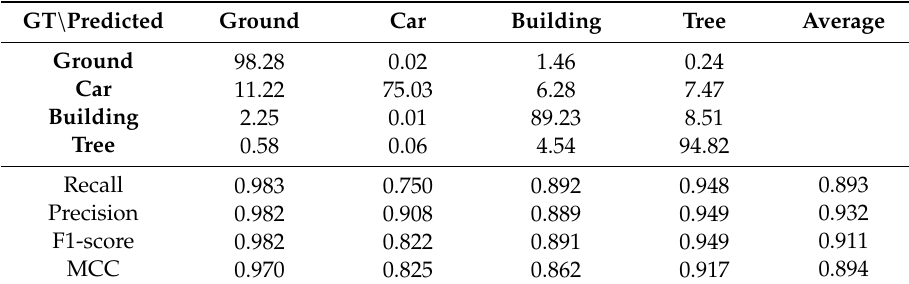
Table 9. Normalized Confusion matrix of ALS_PointNet_1 (%).